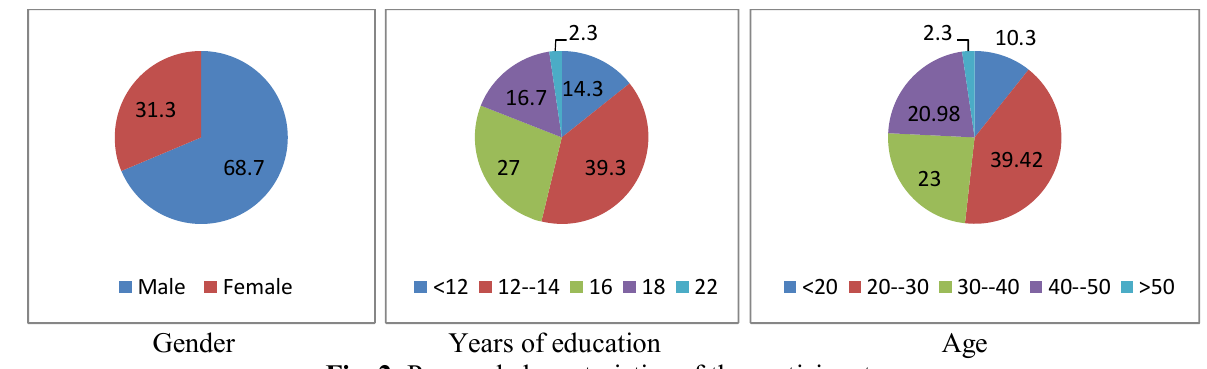
Fig. 2. Personal characteristics of the participants